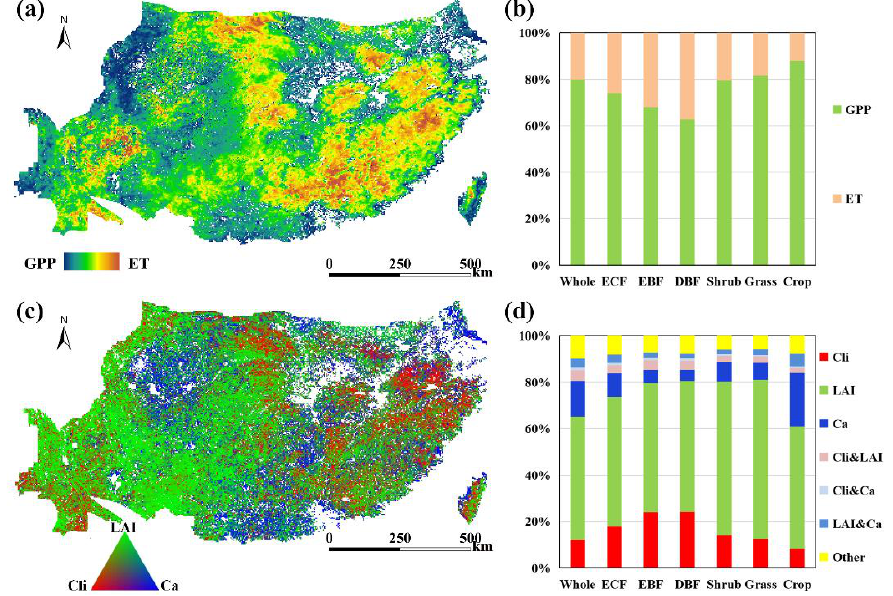
Figure 5. Relative contributions of different driving factors to annual WUE trends based on pixel statistics. ( a ) Spatial patterns of the relative contributions of GPP and ET to WUE trends. ( b ) Controlling area ratios of GPP and ET for WUE trends. ( c ) Spatial patterns of the relative contributions of climate change (Cli), LAI, and Ca to WUE trends. ( d ) Controlling area ratios of the dominant drivers for WUE trends. The combinations of Cli, LAI, and Ca indicate that the coupled impacts of different drivers dominate WUE trends; “other” indicates the equilibrium impact of Cli, LAI, and Ca.